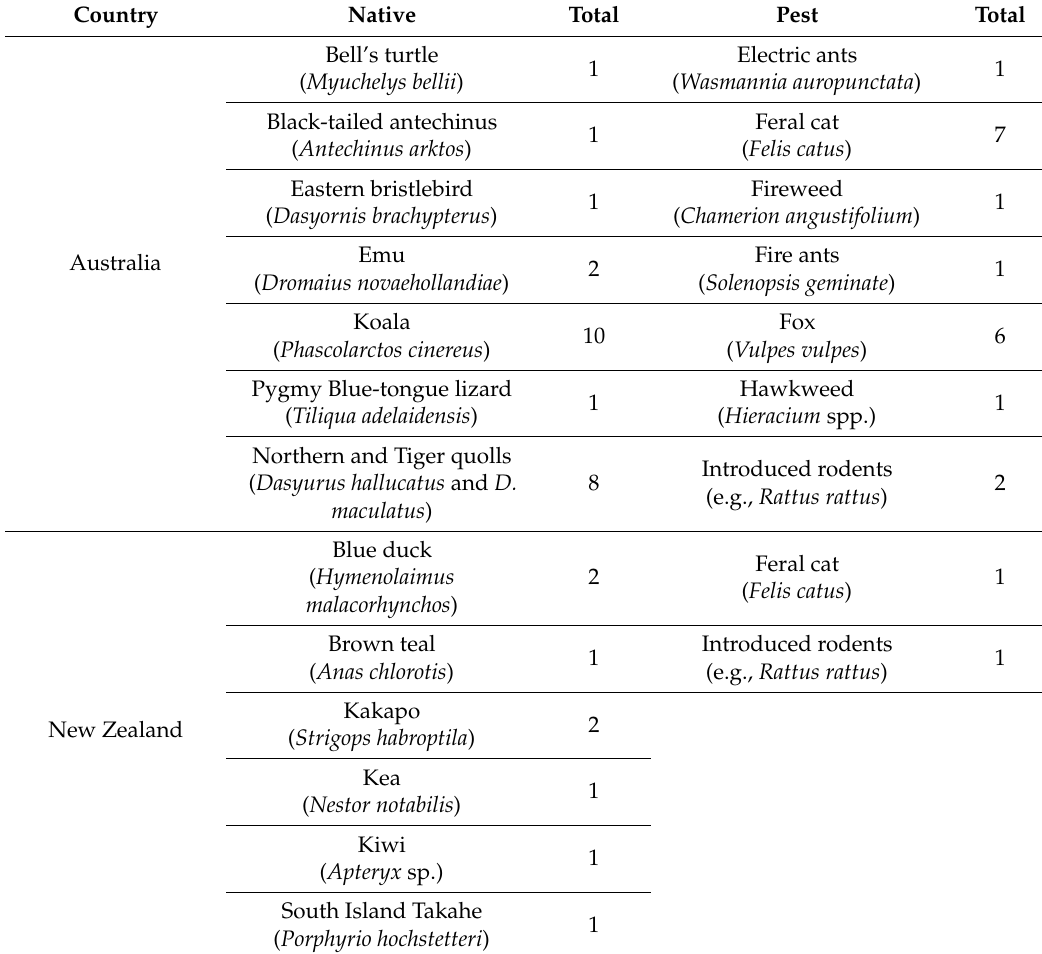
Table 1. Native and pest species, from Australia and New Zealand, listed as target species for the wildlife detection dogs. Total handlers currently handling these species-specific detection dogs are also